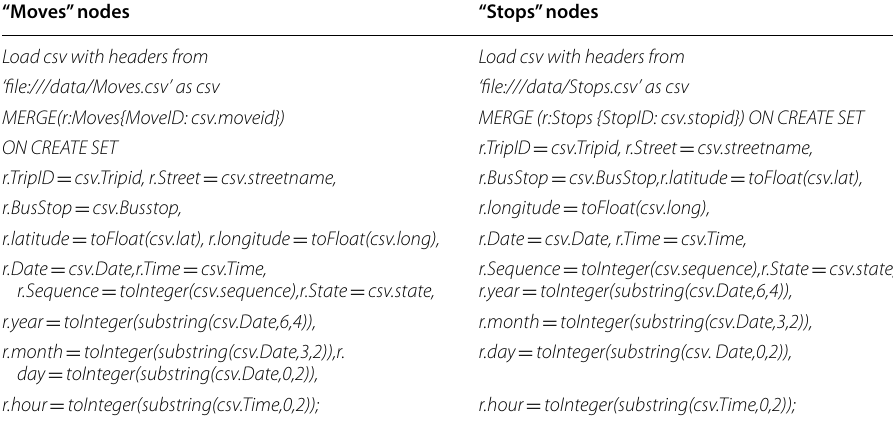
Table 3 Cypher query used to create “Moves” and “Stops” nodes “Moves” nodes “Stops” nodes Load csv with headers from Load csv with headers from ‘file:///data/Moves.csv’ as csv ‘file:///data/Stops.csv’ as csv MERGE(r:Moves{MoveID: csv.moveid}) MERGE (r:Stops {StopID: csv.stopid}) ON CREATE SET ON CREATE